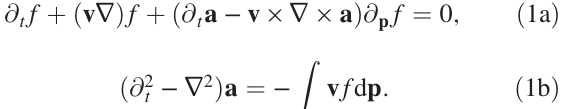
ffiffiffiffiffiffiffiffiffiffiffiffiffiffiffi